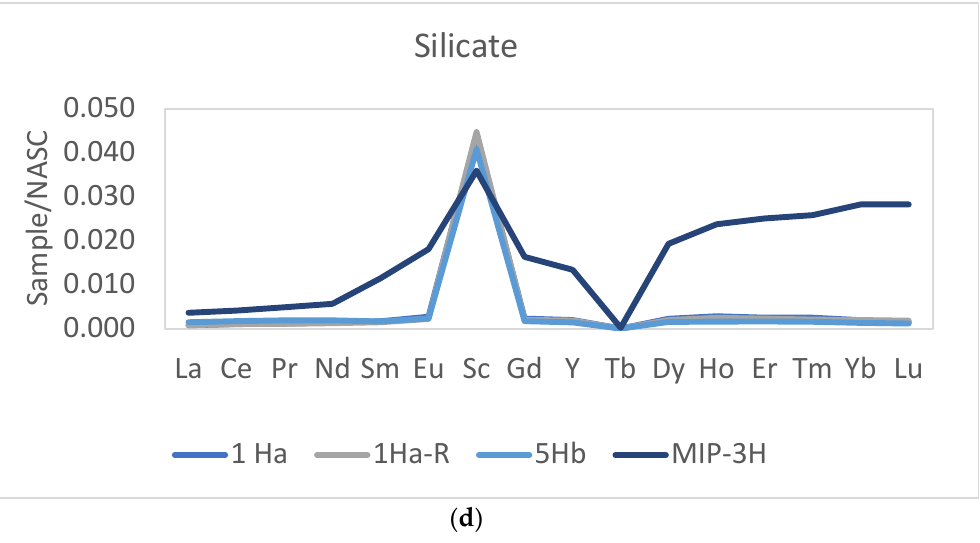
Figure 8. REY patterns in the mineralogical phases: ( a ) carbonate+oxide, ( b ) pyrite+phosphate, ( c ) organics, and ( d ) silicate.